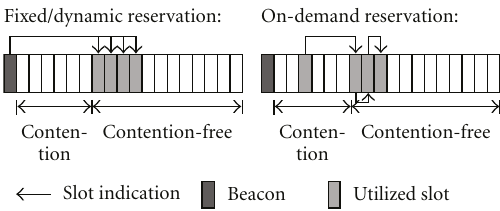
Figure 5: Fixed, dynamic, and on-demand allocation methods.